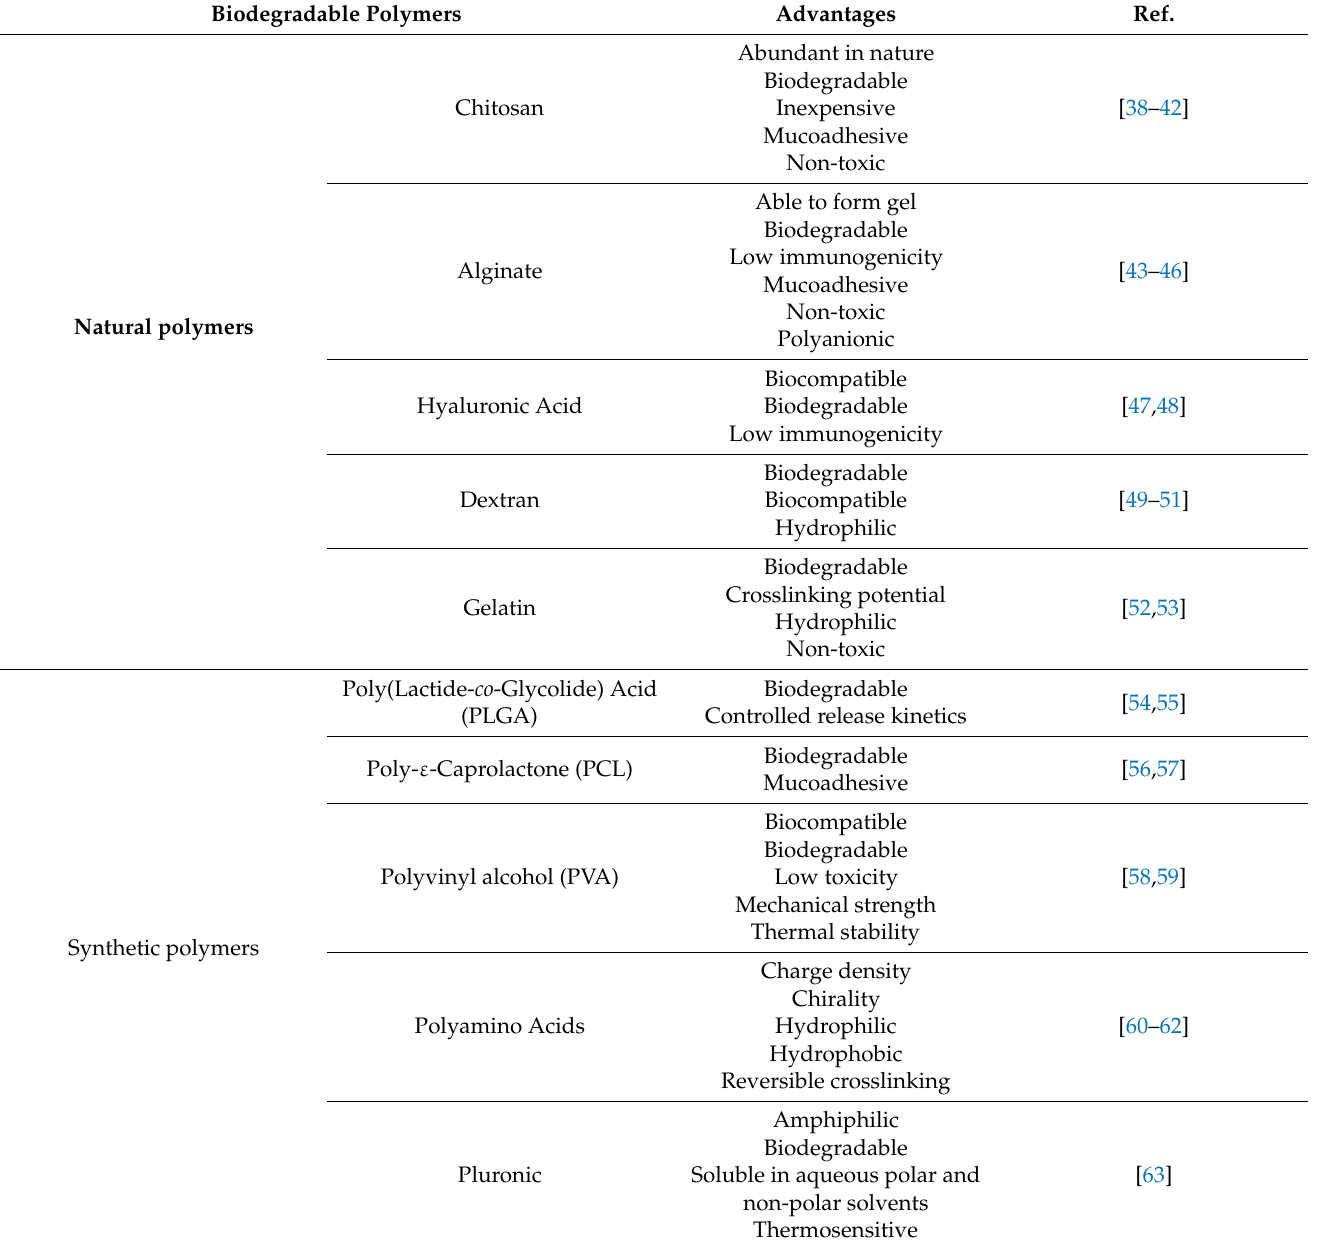
Table 1. Summary of natural and synthetic polymers and their advantages. Biodegradable Polymers Advantages